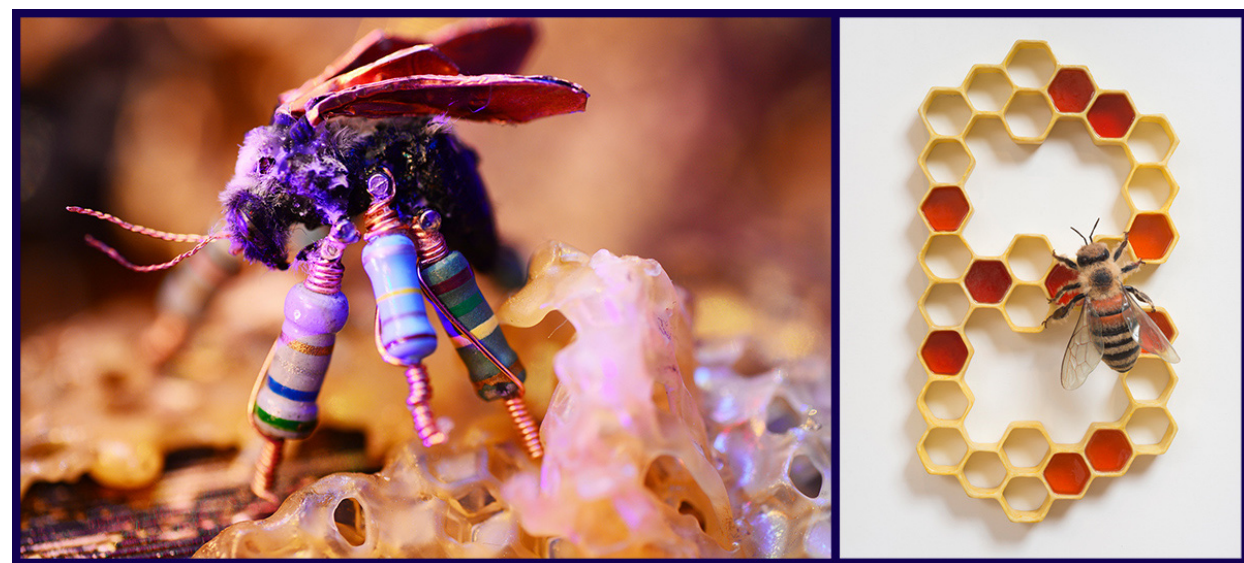
Figure 5. Insect art addressing the intentional modification of insects. The dramatically modified cyborg of a bumblebee specimen ( left ; Cyberhive ; 2019) contributes to Ruth Marsh’s “wry, dystopic vision of a future wherein all bees have perished due to human causes.” Marsh displays bee specimens “repaired” with discarded electronics, and animates them for short films. Victoria Fuller imagines the product of our genetically modifying a honey bee to spell in Spelling Bee ( right ; craft fur, epoxy clay, acrylic, resin, Mylar, Chloroplas; 2014). Both images are courtesy and copyright of the artists. If we exclude artists who addressed more than three categories, the relative pro- portions of artworks conveying messages related to the categories does not markedly change (Table 1). Table 1. Number and percentage of artworks related to categories of human-induced environmental distress. Each artwork potentially relates to more than one category of environmental distress, but each category is calculated here no more than one time per artist. We surveyed 73 artists ( n = 118 category associations), and then surveyed 68 of the artists whose work addresses ≤ 3 of these categories ( n = 97 category associations), to reduce bias from any artist whose work addresses many categories. From top to bottom, the first five categories relate to HIPPO [32]. CCD = colony collapse disorder. Concern indicates general concern for the environment or for insects, when a more specific categorical assignment could not be